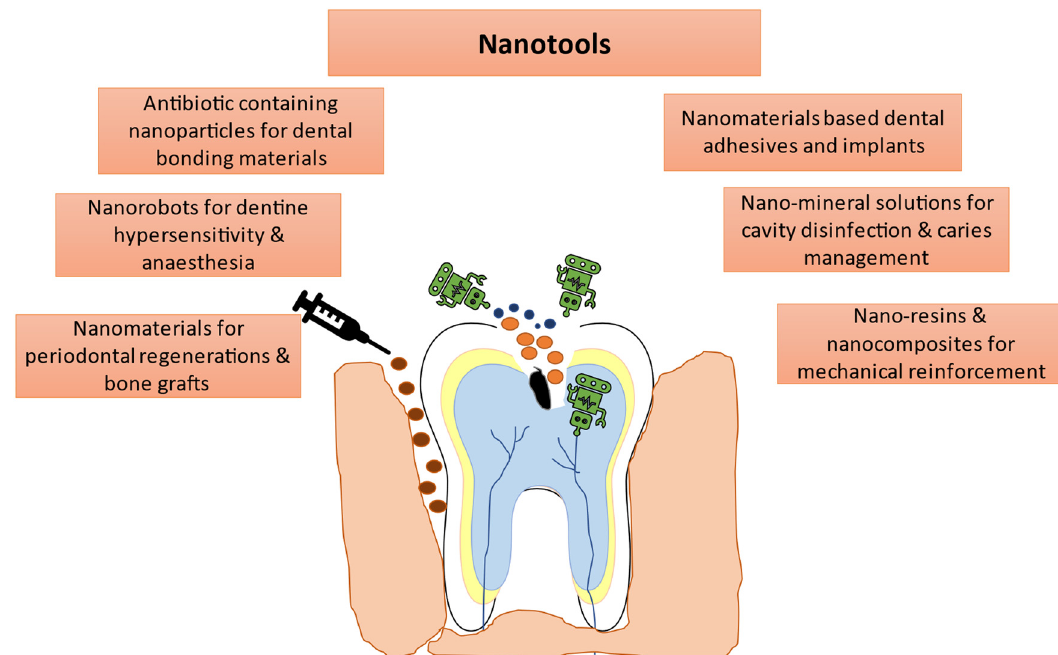
Figure 1: Various nanotools for dental a ffl